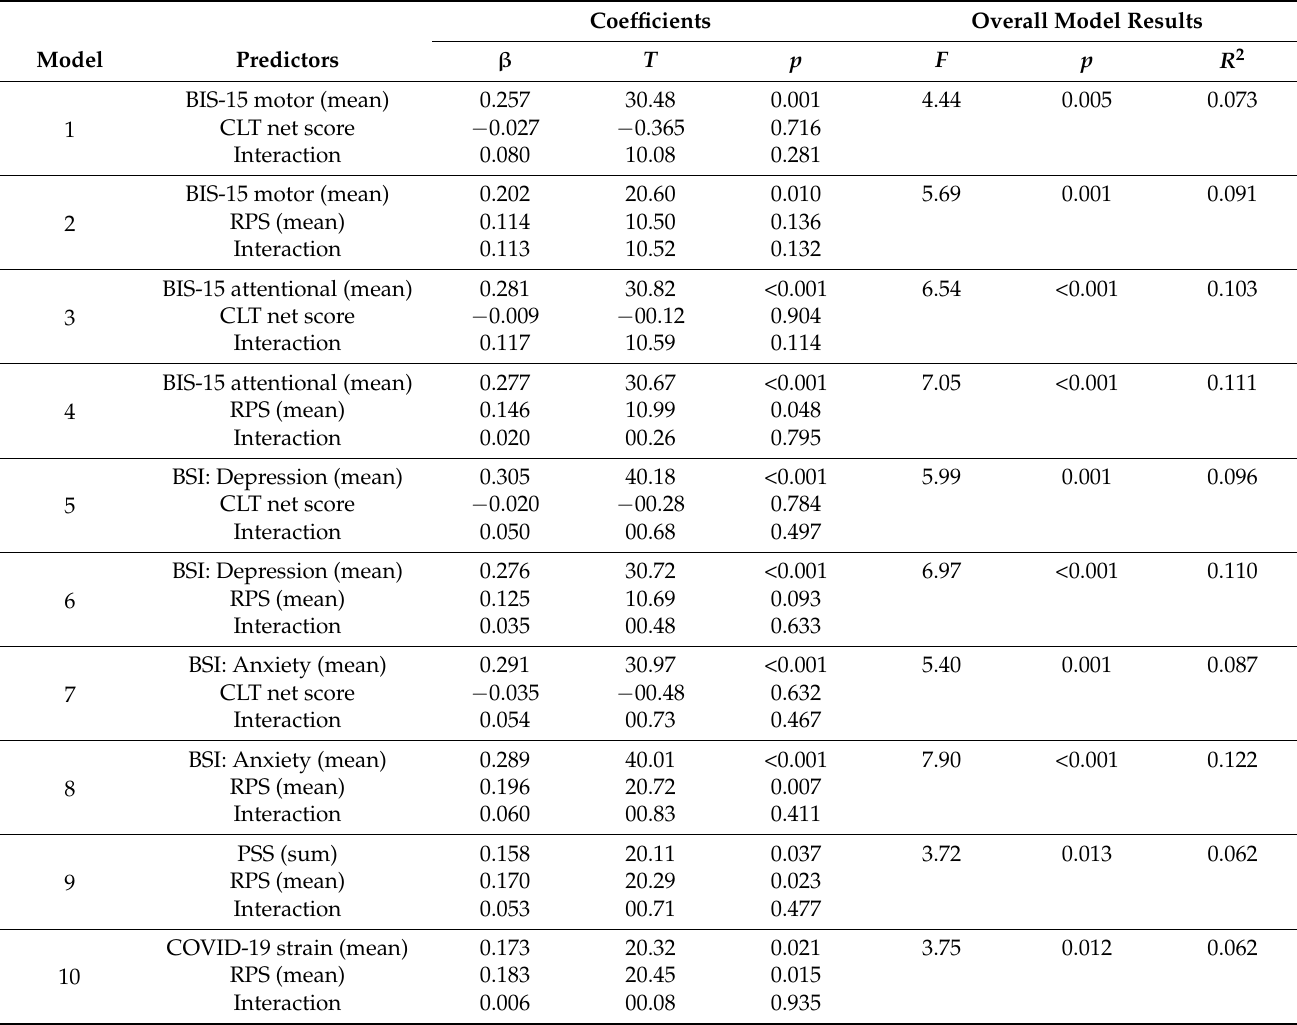
Table 3. Statistics of significant moderated regression models predicting sIUD symptoms. Coefficients Overall Model